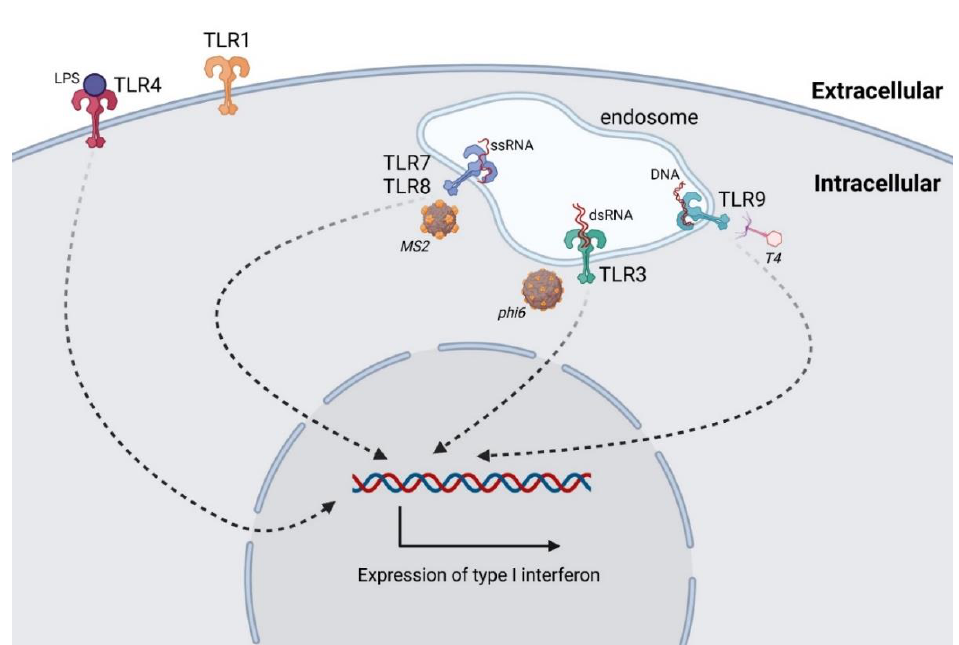
Figure 2. Intracellular interactions of bacteriophages with Toll-like receptors (TLRs). TLRs are capable of recognizing bacteriophage nucleic acids in endosomes (ssRNA (TLR7, TLR8), dsRNA (TLR3), and DNA (TLR9)). The scheme shows hypothetical interactions of bacteriophages with TLRs: bacteriophage MS2 (ssRNA), bacteriophage φ6 (dsRNA), and bacteriophage T4 (DNA). TLR4 can also be activated by LPS present in unpurified phage lysate. The activation of TLRs promotes the expression of type I IFNs.